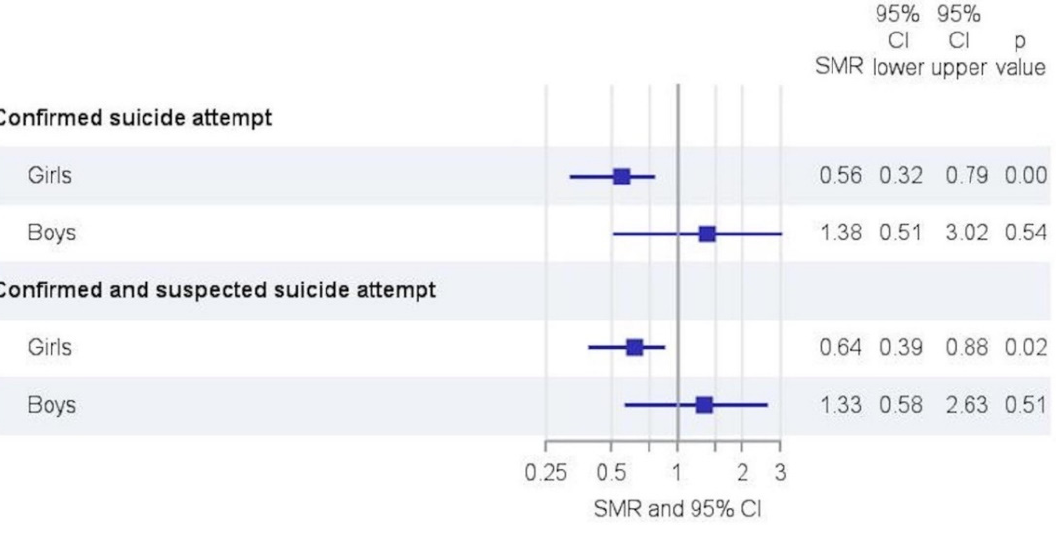
Figure 5. Trends in confirmed and suspected suicide attempts in adolescents. SMR, standardized morbidity rate; CI, confidence interval.